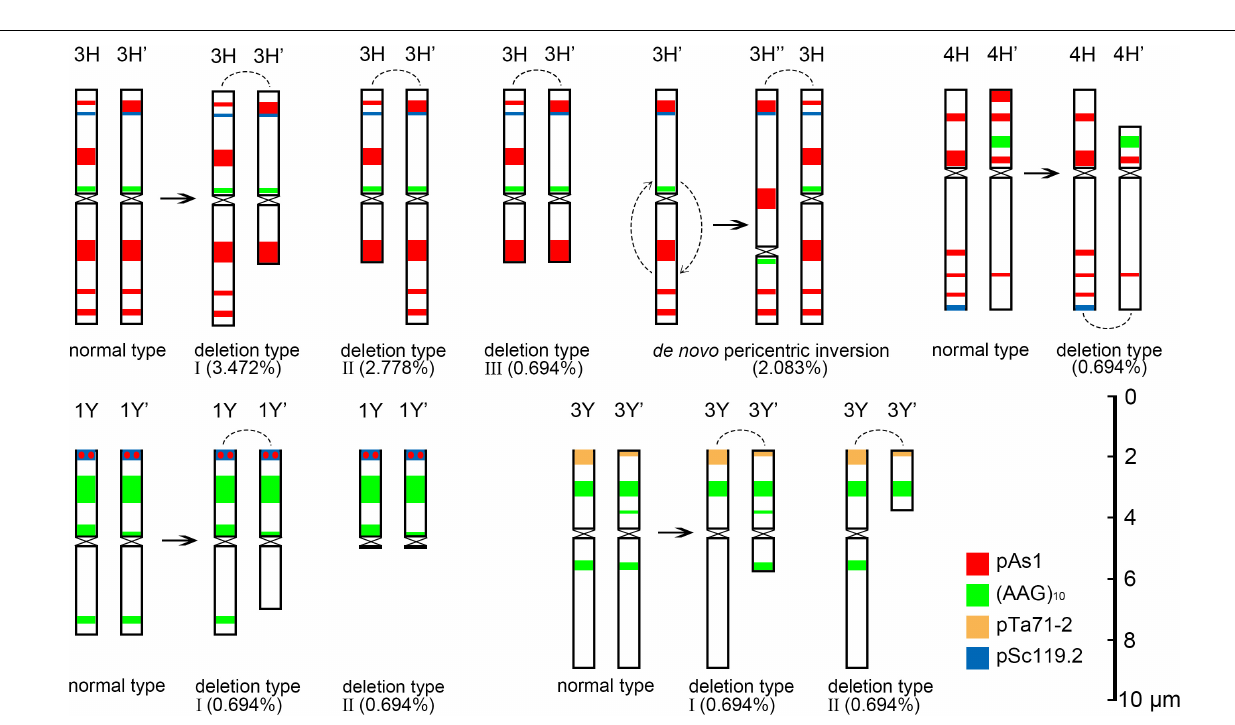
Frontiers in Plant Science |